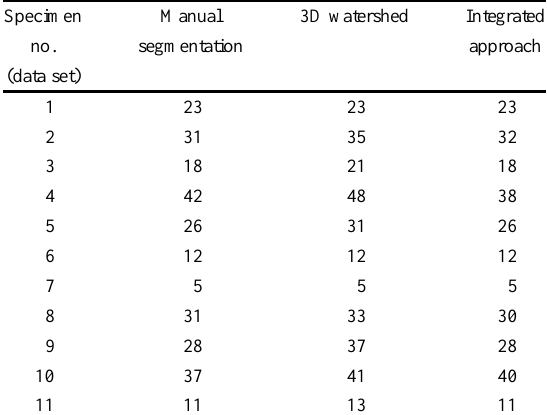
Comparative results of number of cells uniquely labeled by water- shed and integrated technique for segmentation Specimen 3D